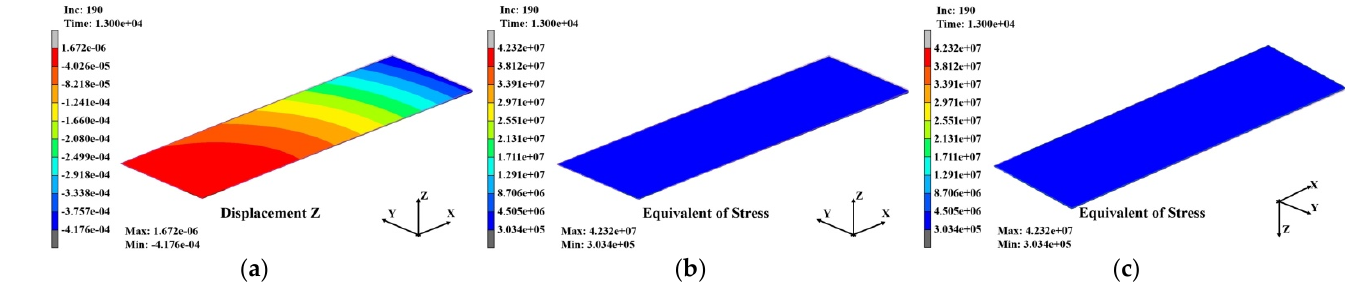
Figure 21. Analysis results of the substrate after SR laminating: ( a ) warpage distribution (0.42 μ m); ( b ) stress distribution (42.3 MPa); ( c ) stress distribution at bottom view (42.3 MPa).